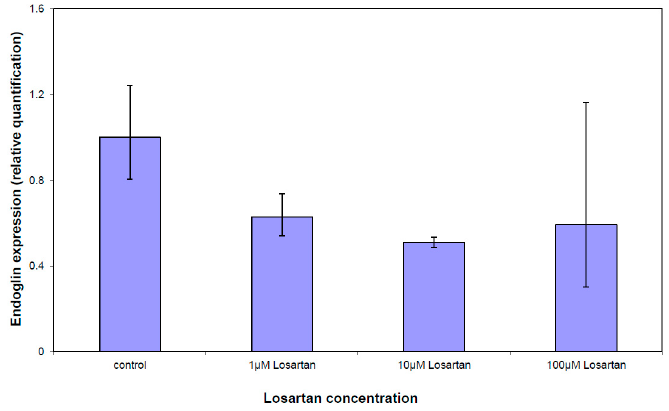
Figure 6. Single real-time RT-PCR of endoglin after WG-59 treatment with increasing losartan concentrations. Increasing the losartan concentration could not downregulate endoglin expression significantly.